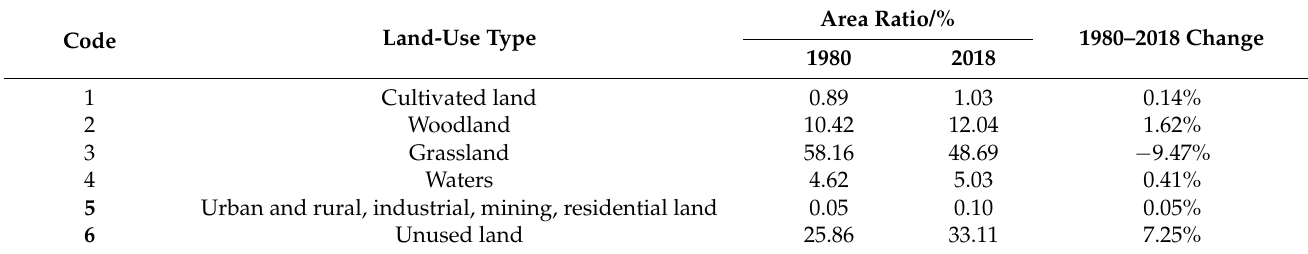
Figure 7. The main spatial transfer of land-use types from 1980 to 2018. Table 3. Statistics of land-use changes on the QTP from 1980 to 2018.